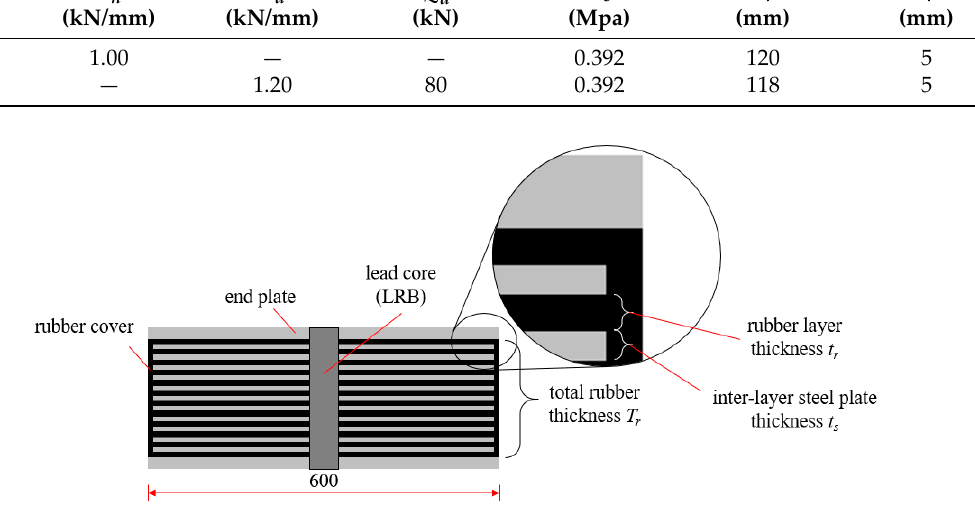
Figure 2. Profile of the specimen (unit: mm) Table 1. Mechanical properties of the rubber bearings